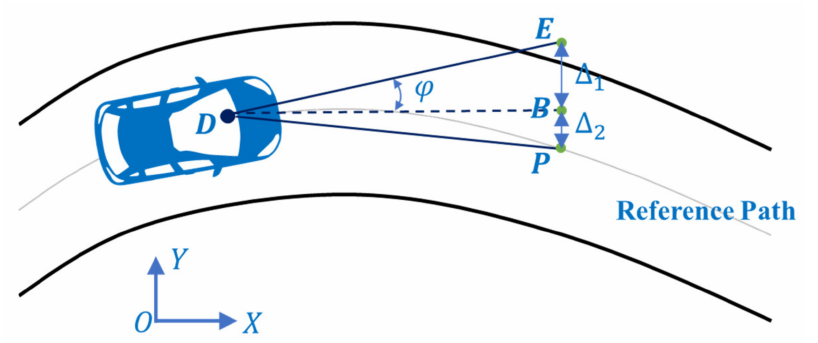
Figure 2. Driver